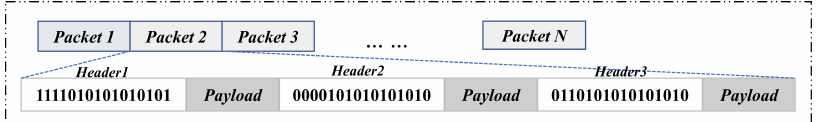
Figure 10. The signal construction with repetitive packet transmission in a color channel. For all packets, the headers comprised the same three sequences.